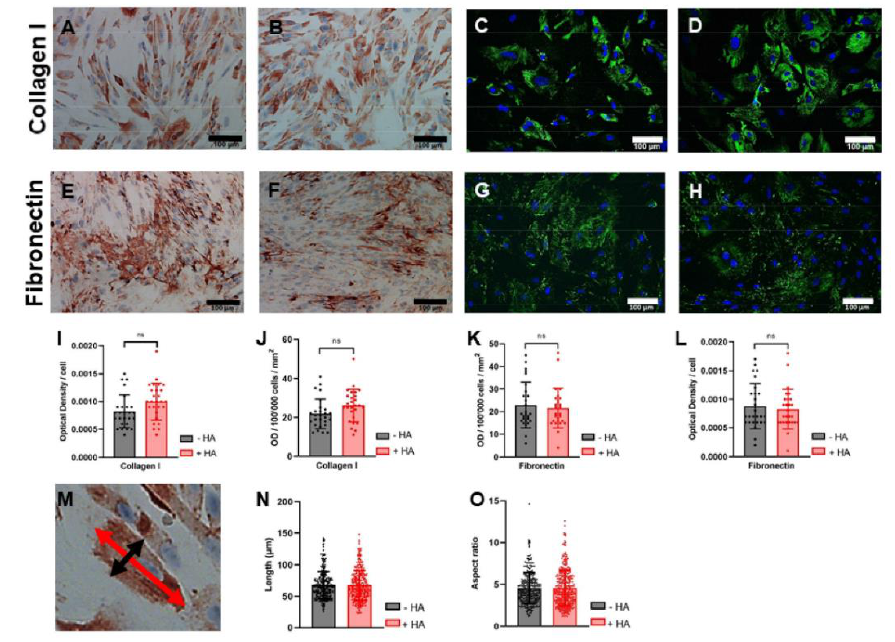
Figure 7. DAB-stained rabbit tenocytes for collagen I ( A , B ) and fibronectin ( E , F ), and fluorescence staining for collagen I ( C , D ) and fibronectin ( G , H ), without HA supplementation ( A , C , E , G ) or with HA supplementation ( B , D , F , H ). Quantitative results of optical densities of collagen I ( I , J ) and fibronectin ( K , L ), showing higher ODs correlated with more intense staining. Quantitative analysis of cell morphology ( M ), regarding cell length ( N ) and aspect ratio (length to width) ( O ) of tenocytes in the presence of HA or in the control medium. (Scale bar: 100 µm).